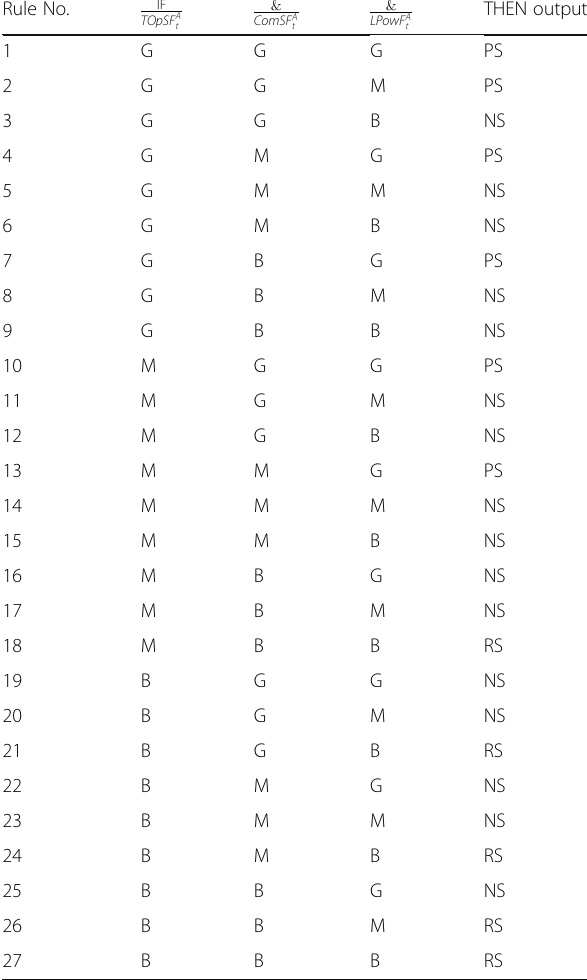
Table 3 Fuzzy rules employed in designing FNSSDS ( α is the output) Rule